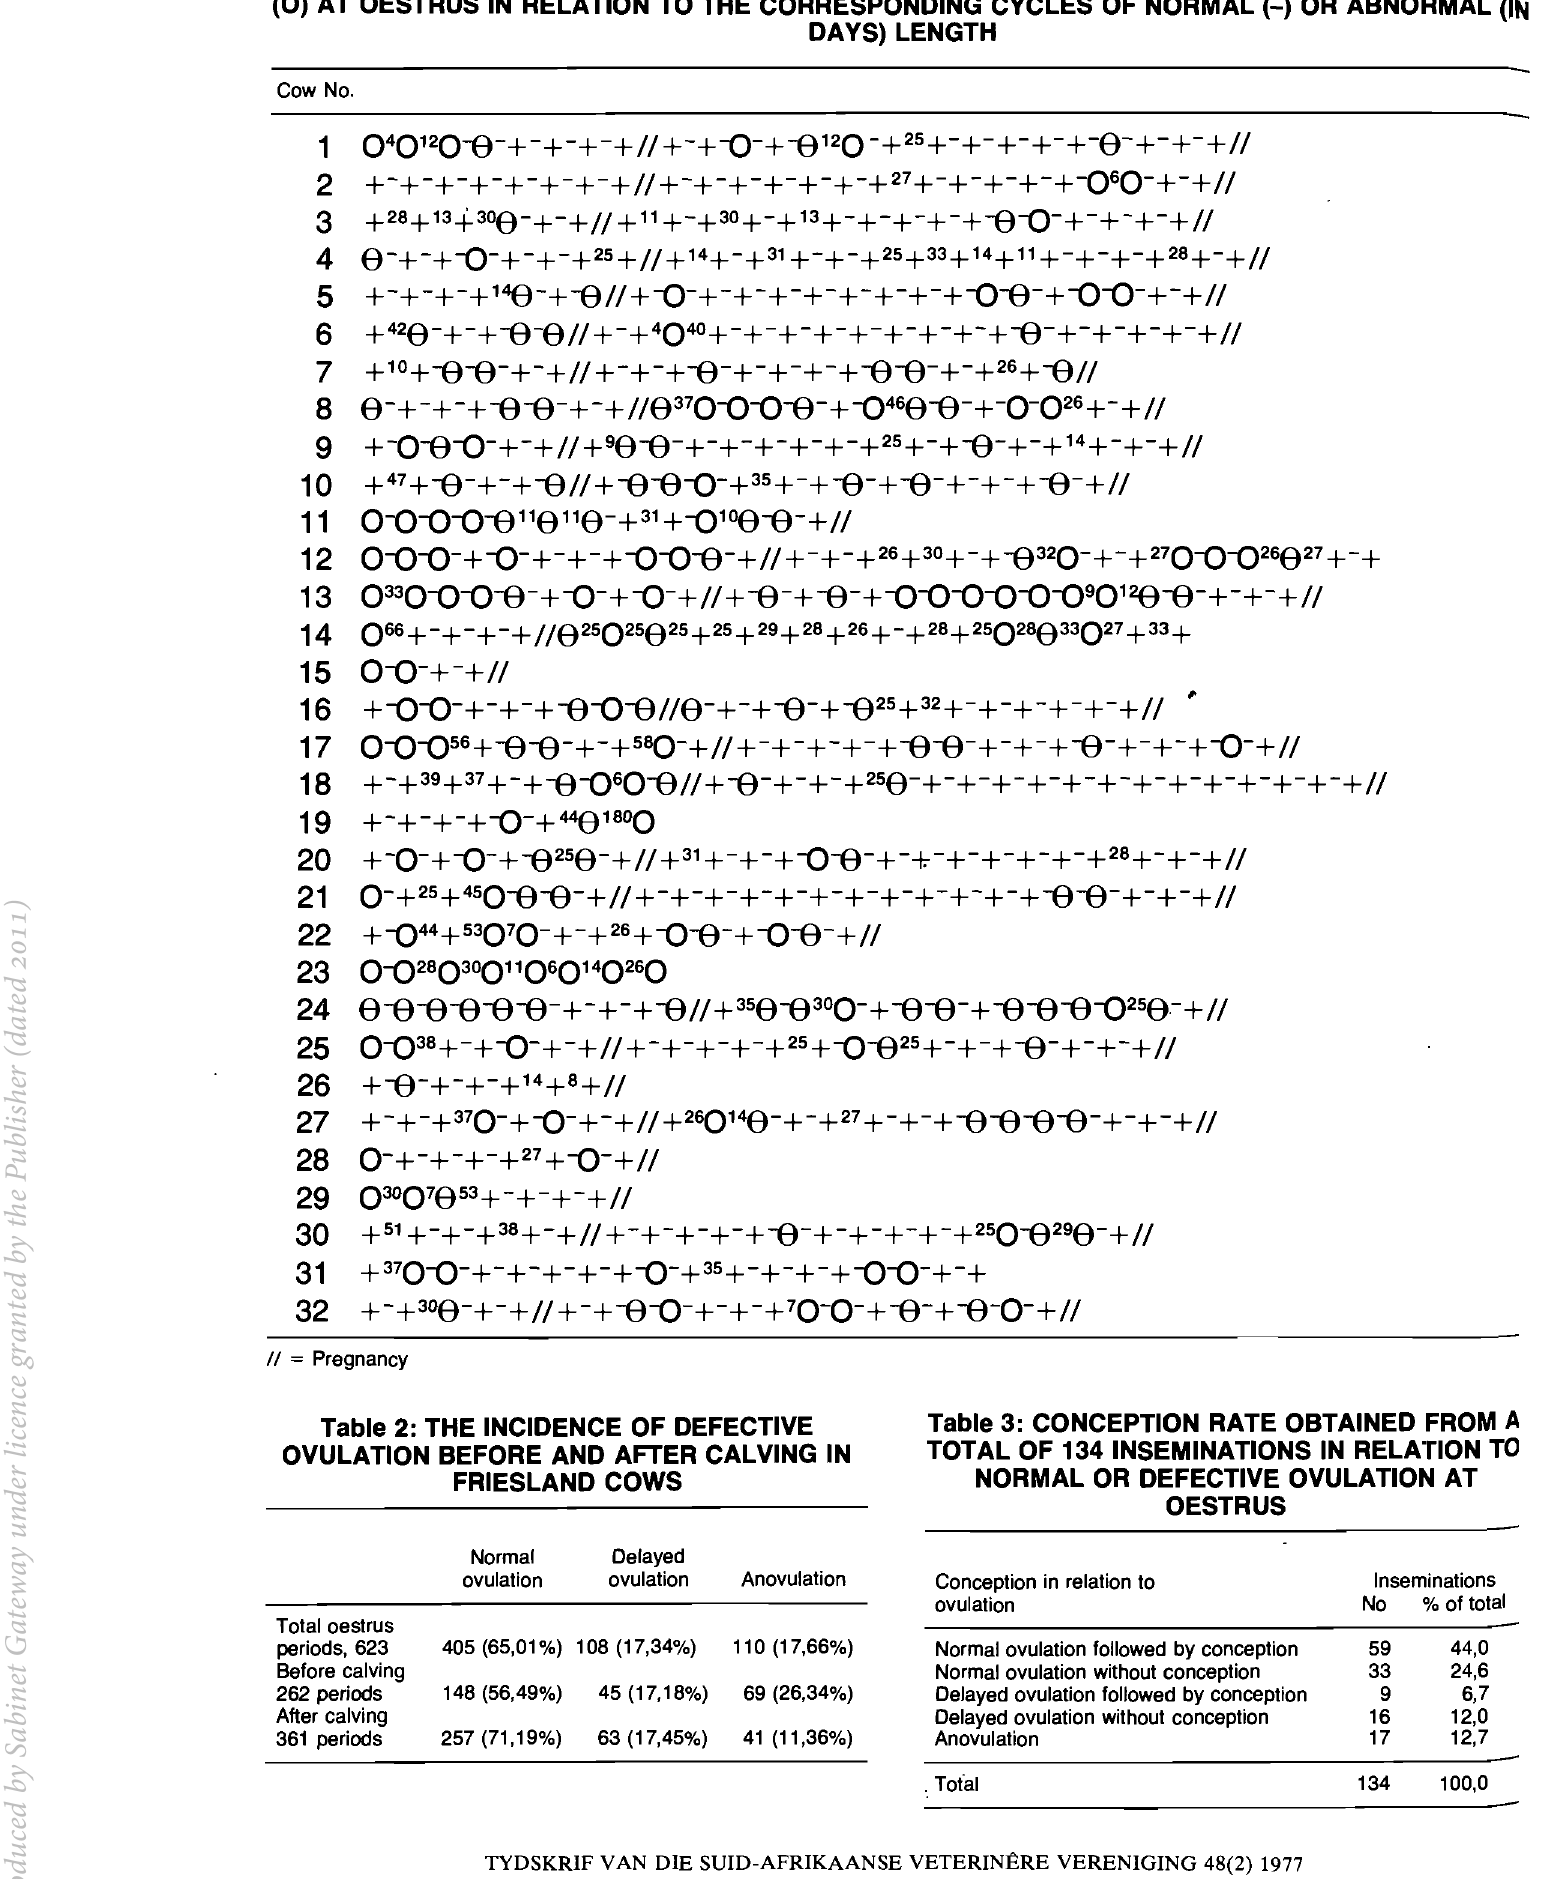
Table 1: THE SEQUENCE OF NORMAL OVULATION (+), DELAYED OVULATION (8) AND ANOVULATION (0) AT OESTRUS IN RELATION TO THE CORRESPONDING CYCLES OF NORMAL (-) OR ABNORMAL (IN DAYS) LENGTH Cow No.